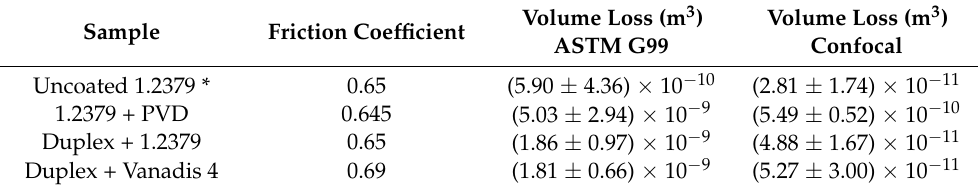
Table 7. Summary of the experimental data on the friction coefficient and volume loss measured by ASTM G99 and confocal microscopy for each sample. * The test parameters for the uncoated sample were different to those for the